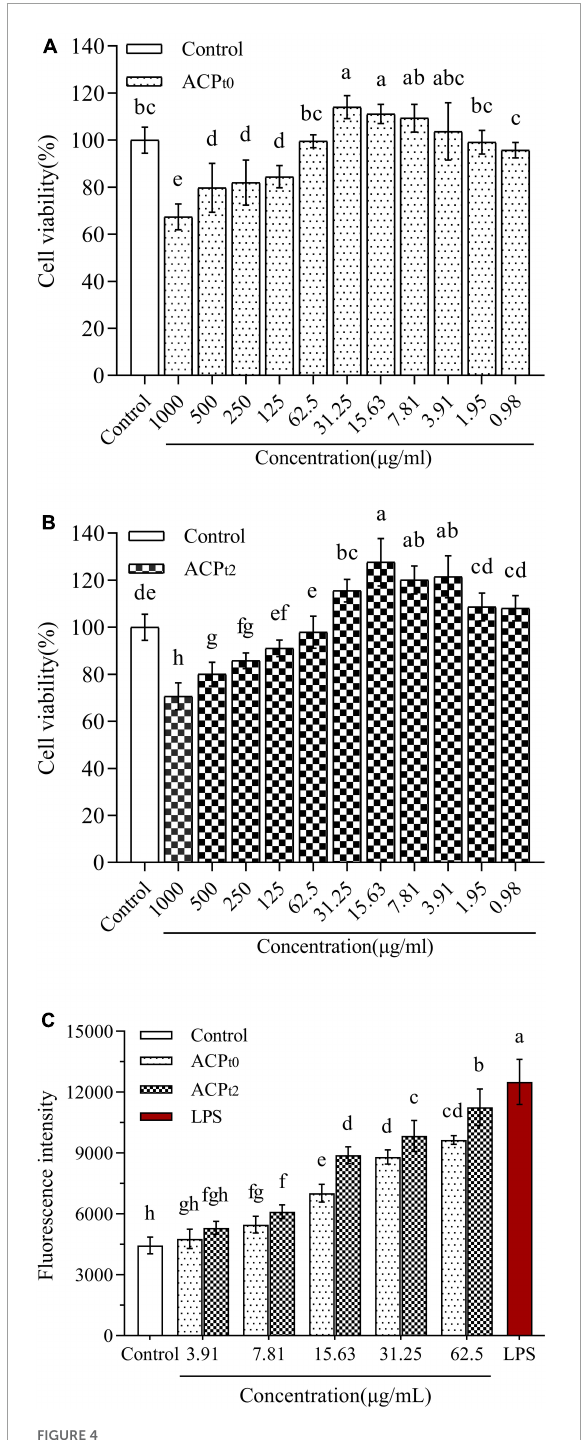
FIGURE4 The effects of ACP t 0 (A) and ACP t 2 (B) treatment on the viability of macrophages. Effect of different concentrations of ACP t 0 and ACP t 2 treatment on ROS generation of macrophages (C) . The different letters in the column indicate statistically significant differences ( P <